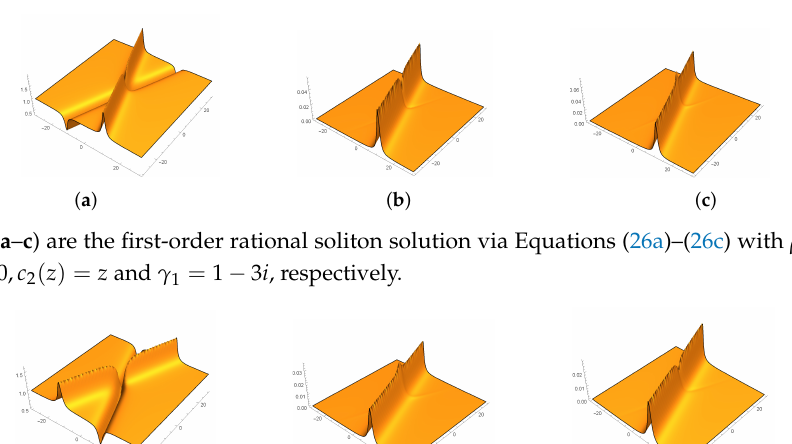
Figure 6. ( a – c ) are the first-order rational soliton solutions via Equations (26a)–(26c) with ρ = 0.5, φ = 0, c 1 ( z ) = 0, c 2 ( z ) = z and γ 1 = 1 − 0.1 i , respectively.